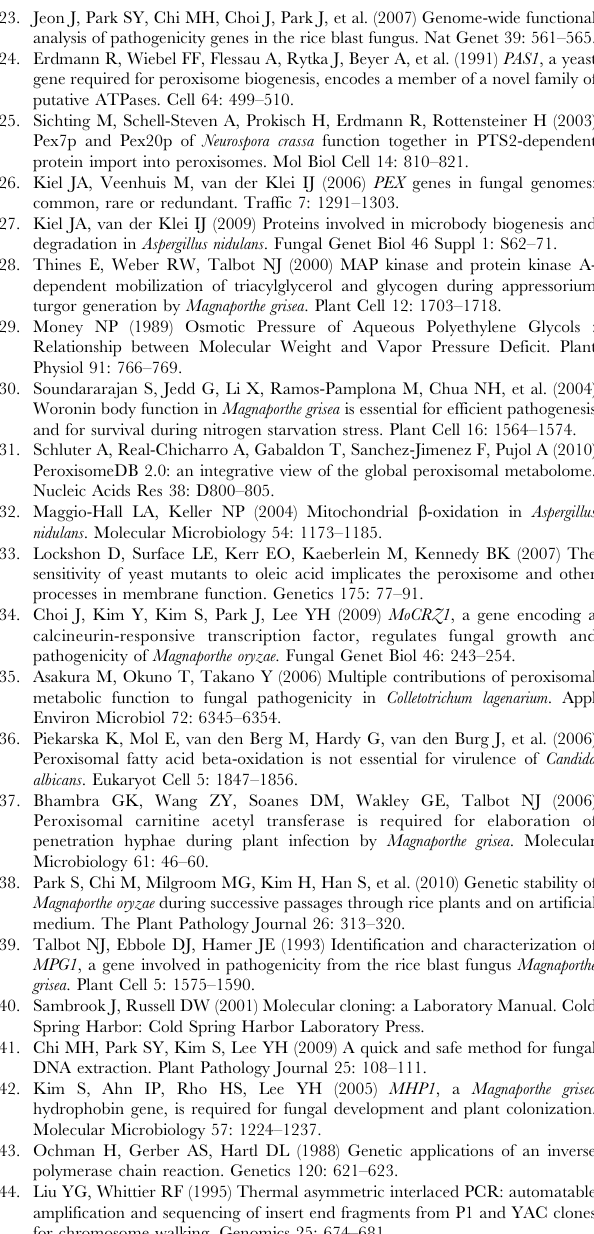
Figure S2 Phylogenetic analysis of PEX7 in fungi. (TIF) Figure S3 Penetration ratio of D Mopex7 with addition of 2.5% glucose or 1 mM scytalone on onion epidermal surface at 36 h. Figure S4 Tricyclazole sensitivity of D Mopex7 . Melanized appressoria ratio was observed at 24 h under a light microscope. Figure S5 Cell wall integrity of D Mopex7 . (A) Protoplast production from cell wall degrading enzyme treatment. (B) Growth on complete media with cell wall synthesis inhibitor at 8